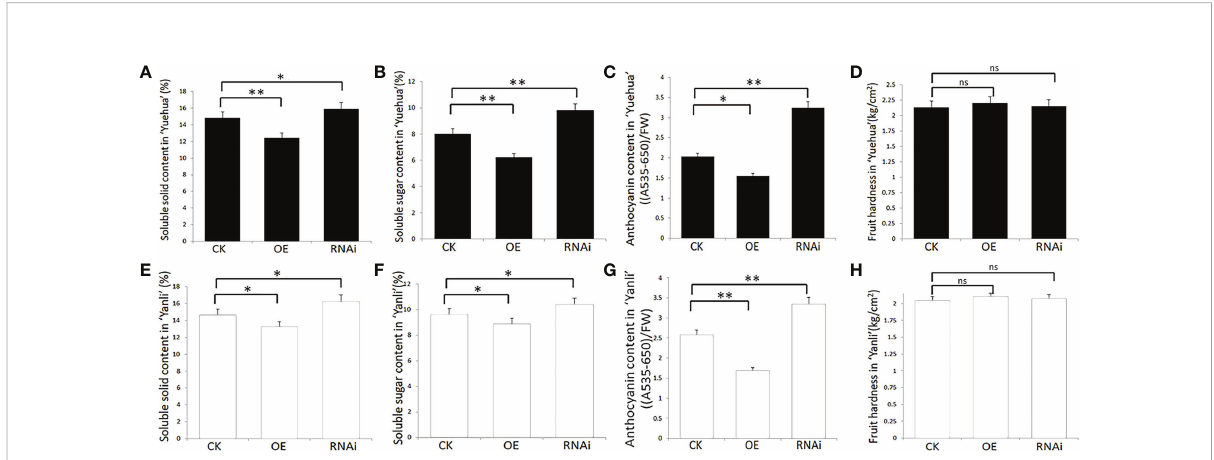
FIGURE 5 Physiological indexes of transgenic strawberry fruit in ‘ Yuehua ’ and ‘ Yanli ’ . Soluble solid, soluble sugar, and anthocyanin content and fruit hardness in transgenic (A-D) ‘ Yuehua ’ and (E-H) ‘ Yanli ’ fruit, respectively. Values are the mean ± SD from three independent experiments with three biological replicates. ‘ * ’ Indicates signi fi cant difference (P < 0.05, Duncan ’ s multiple range test); ‘ ** ’ indicates very signi fi cant differences (P < 0.01, Duncan ’ s multiple range test); ns indicates no signi fi cant difference.